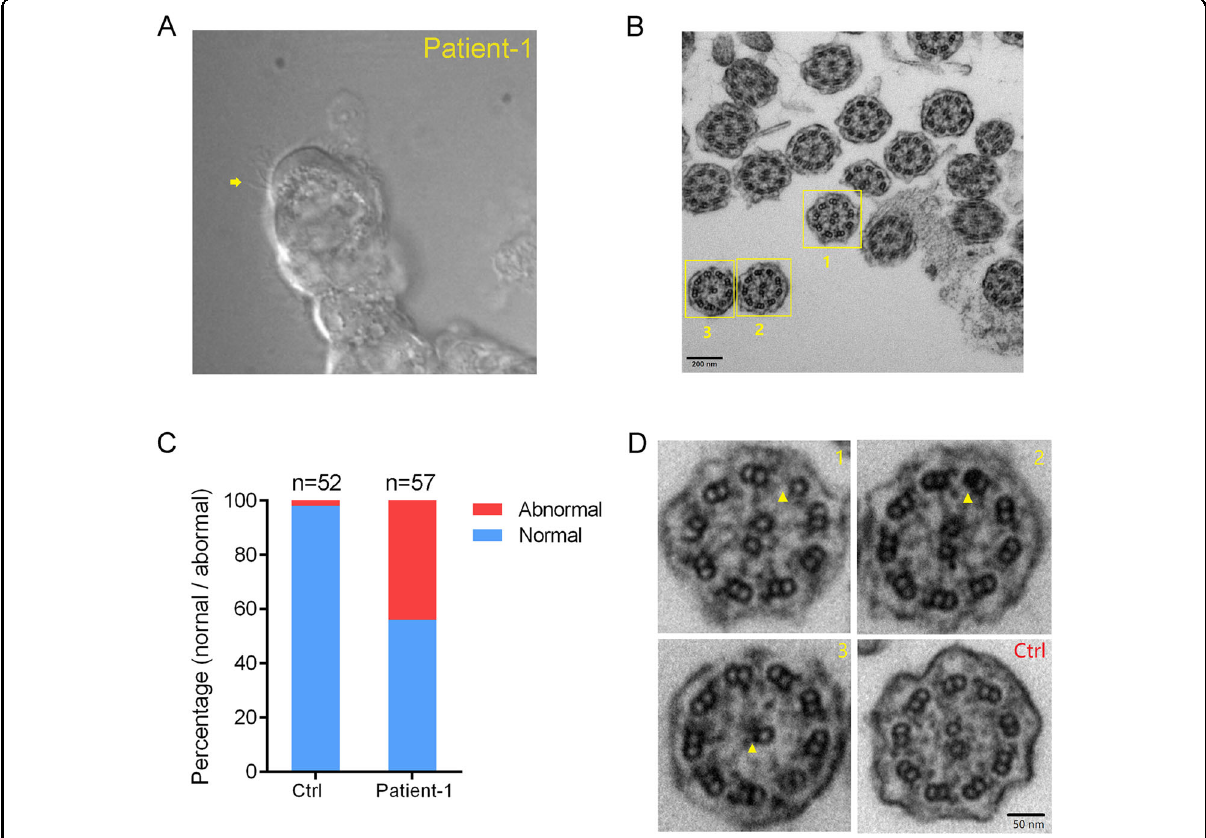
Fig. 5 Defective ciliary ultrastructure in Patient-1 with NEK3 biallelic mutations. b Representative image showing primary nasal respiratory epithelial cells of Patient-1 by an optical microscope. Paucity of cilia was observed and indicated by yellow arrow. b Representative image of transmission electron micrographs (TEM) of ciliary axonemes in cross-section from Patient-1. Scale bar, 200 nm. c Percentage of abnormal ciliary ultrastructures in the Patient-1 and healthy individual. d Compared with a healthy individual (Ctrl), multiple ultrastructural abnormalities (#1 – 3) including the absence of the central-pair microtubules and nine peripheral microtubule doublets were identi fi ed in the Patient-1 that highlighted by yellow arrowheads. Scale bar, 50